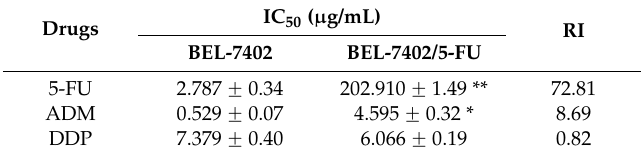
Table 1. Sensitivity of BEL-7402 cells and BEL-7402/5-FU cells to chemotherapeutic drugs.